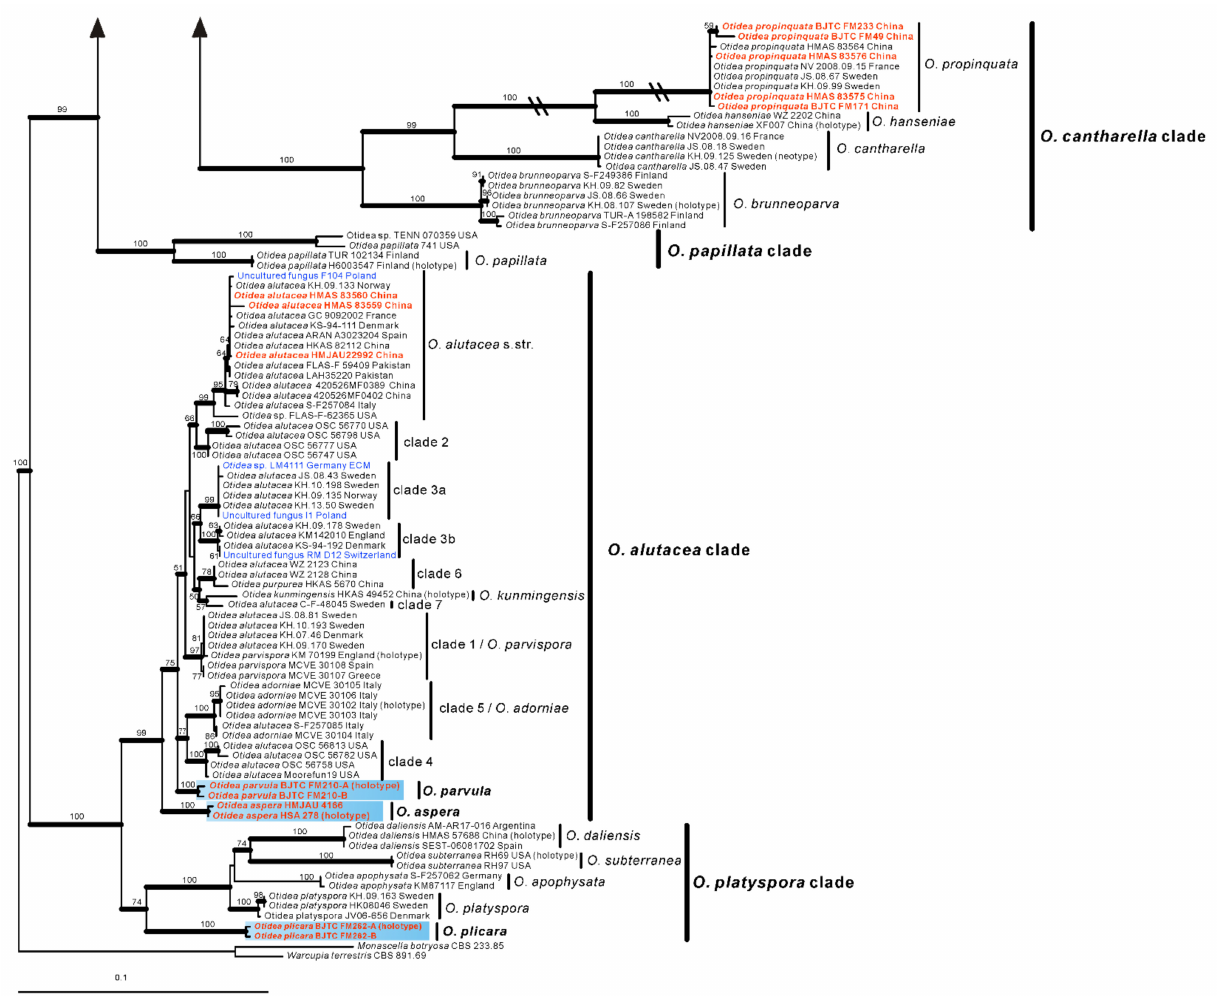
Figure 1. Phylogenetic tree generated from maximum likelihood analysis based on ITS and nrLSU sequences, showing the phylogenetic relationships of Otidea . Monascella botryosa and Warcupia terrestris are the outgroups. Maximum likelihood bootstrap support values ( ≥ 50%) are indicated above the nodes as BS. Thick black branches received Bayesian posterior probabilities (BPP) ≥ 0.95. Novel sequences are printed in bold red. Mycorrhizal or environmental sequences are printed in blue. The new species are in bold font and highlighted by blue